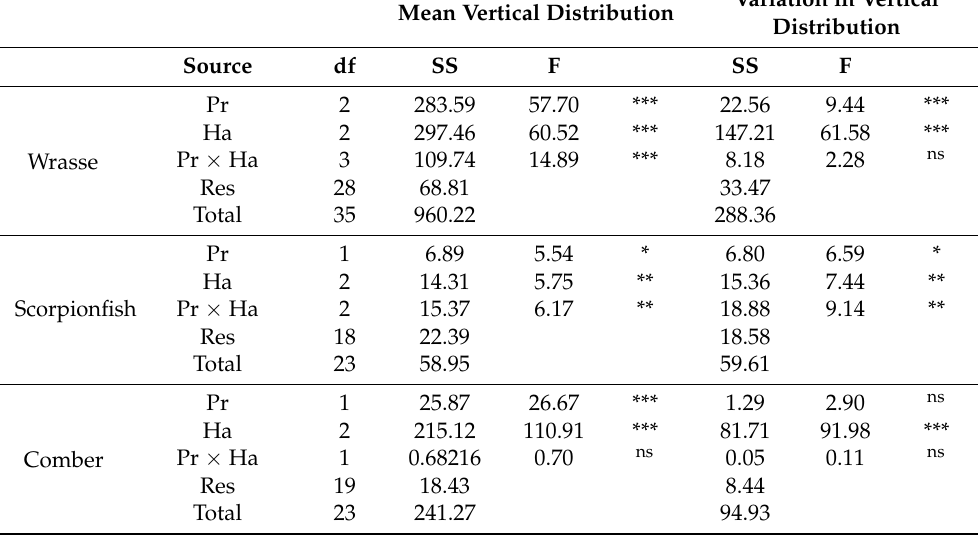
Figure 4. Vertical distributions of prey and predators depending on vegetation height and predator– prey treatments: ( A ) values averaged over replicates [95% CI] of the means (Mean position) and the SDs (Variation in position) of every individual’s vertical distributions. Results of pair-wise comparisons post hoc to ANOVA (Table 3) are reported using equal/unequal symbols or lowercase letters. ( B ) Mean frequencies [95% CI] of the time spent within the vegetated strata (0 to 5 cm in Shrub, 0 to 15 cm in Forest) and within open water. The intensity of shading is proportional to mean values. Table 3. PERMANOVA on mean and variation of fish individual’s vertical distribution. For each species (the prey wrasse, the predator scorpionfish, the predator comber), comparison of mean vertical position and variation in vertical position between habitat treatment (Ha, 3 levels: Forest (F), Shrub (S), Barren (B)) and predator–prey treatments (Pr, 3 levels for the prey: the prey alone (W), the prey and the scorpionfish (SW), the prey and the comber (CW); 2 levels for each predator: the predator alone vs. the predator and the prey). ns not significant; * p < 0.05; ** p < 0.01; *** p < 0.001. Results of pair-wise comparisons are indicated in Figure